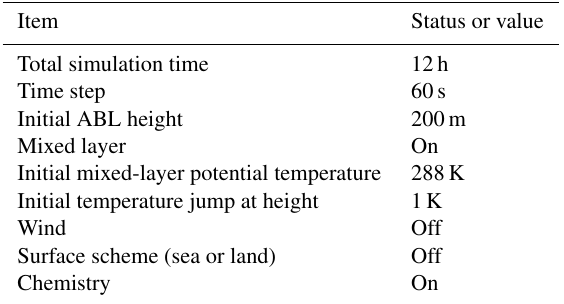
Table 1. Configuration and settings of the CLASS modelling sys-